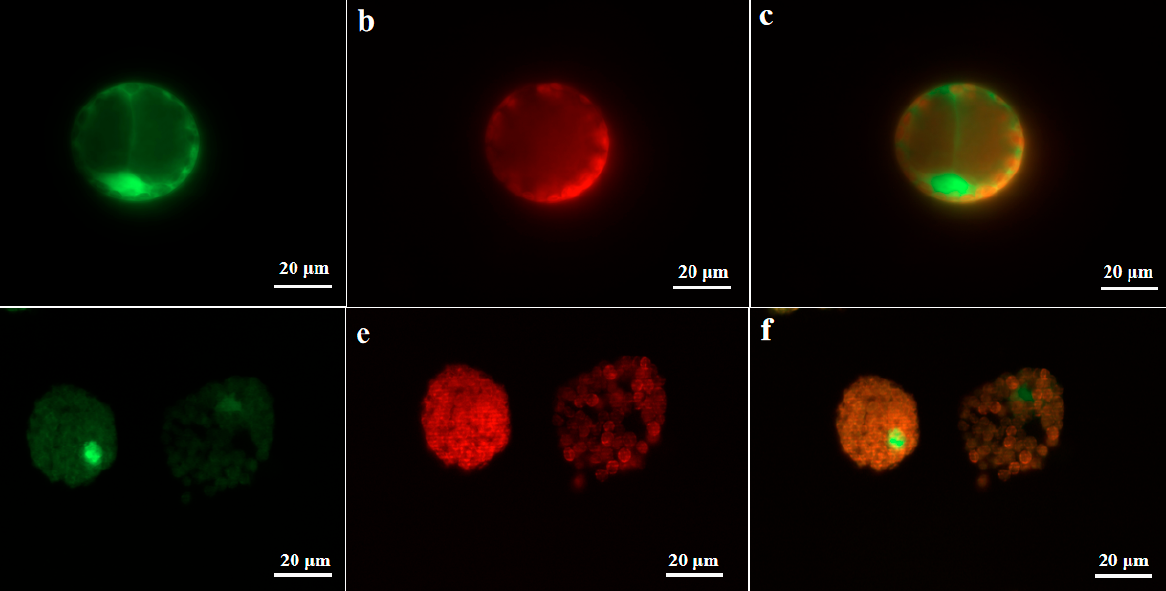
Figure 6. The subcellular localizations of UrWRKY37 using U. rhynchophylla protoplasts. Subcellular localization of pBI121-GFP ( a – c ) empty vectors and pBI121-UrWRKY37-GFP ( d – f ) in U. rhynchophylla protoplasts under a fluorescence microscope. ( a , d ) Protoplast with GFP. ( b , e ) Chlorophyll autofluorescence (Chl). ( c , f ) Merged images were simultaneously exhibited. Bars = 20 µm.